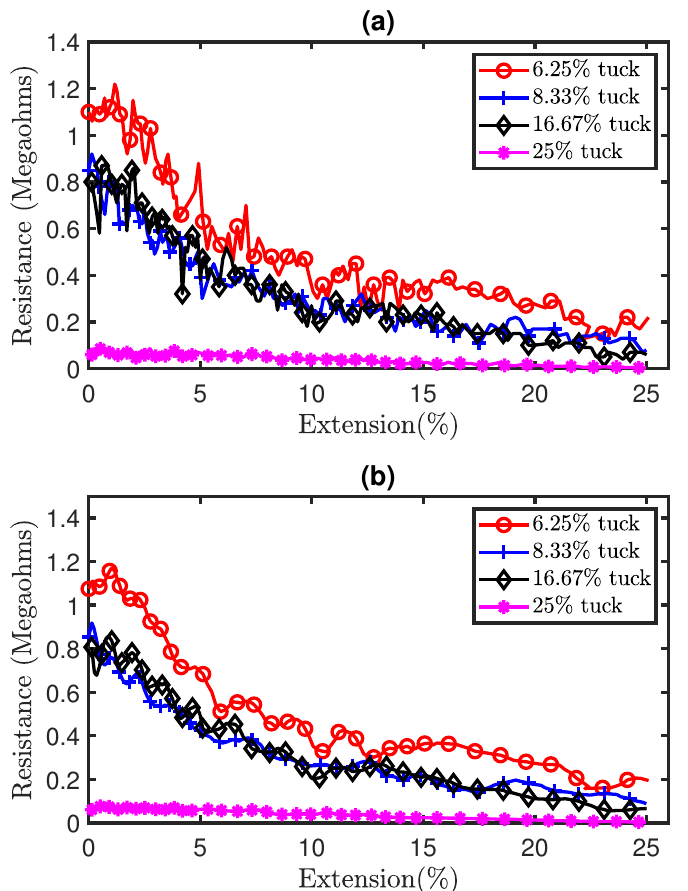
Figure 9. Experimental results of tensile test on sensors with tuck stitches. ( a ) Pre-filtered results, ( b ) Post-filtered results.